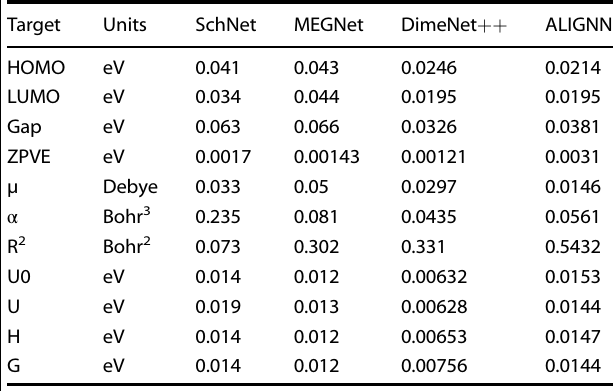
Table 5. Regression model performances on QM9 dataset for 11 properties using ALIGNN.